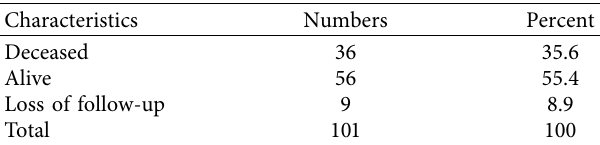
Table 6: The outcome of patients diagnosed with colorectal car- cinoma operated on at